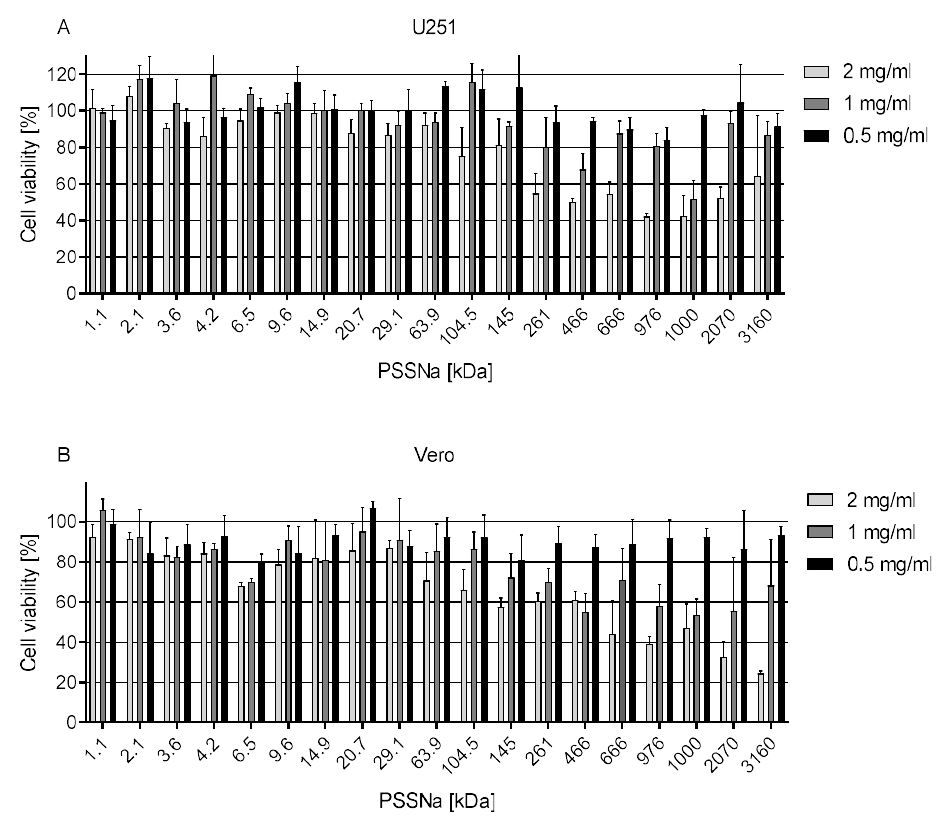
Figure 1. Cytotoxicity of PSSNa of various MWs at 2000, 1000, and 500 µ g / mL. Results of XTT assay of the tested polymers on U251 ( A ) and Vero cells ( B ). All experiments were performed in triplicate. Average values with standard deviations (error bars) are presented.